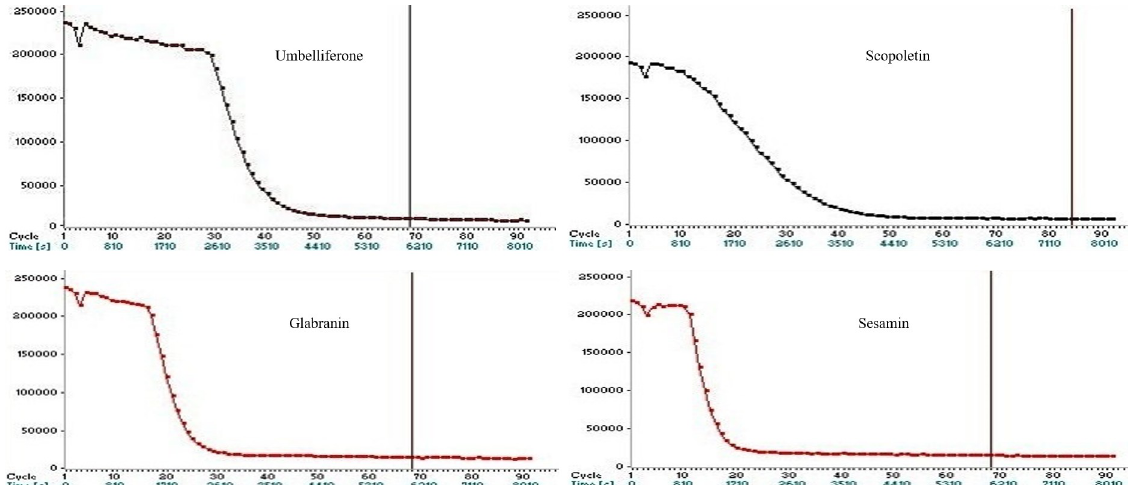
Fig 2. Fluorescence decay curves of fluorescein induced by AAPH in the presence of umbelliferone (7), glabranin (6), scopoletin (8) and sesamin